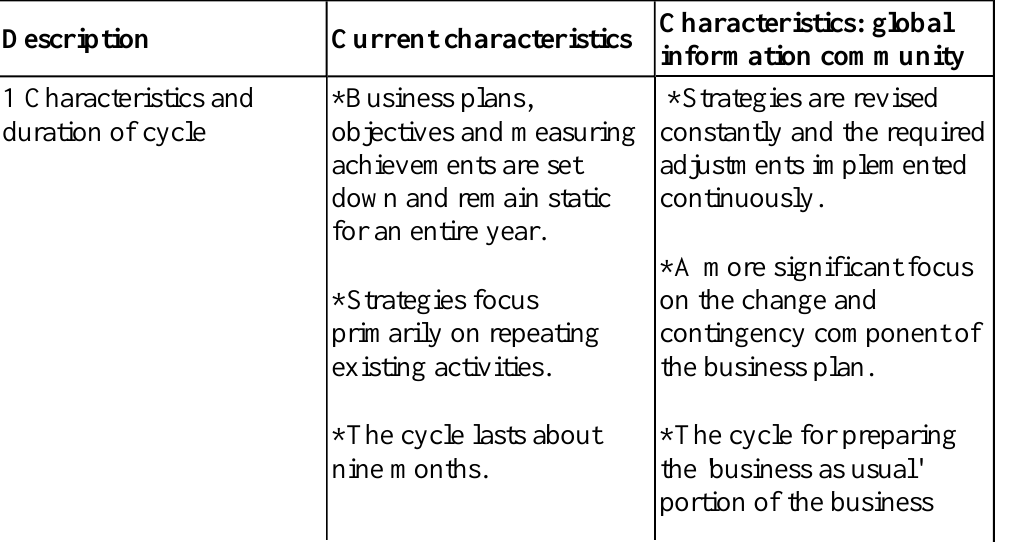
Table 1 Possible future